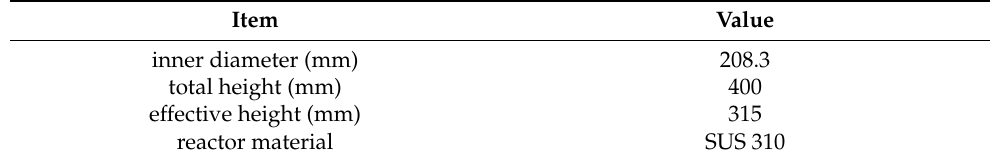
Figure 8. Rotary cylindrical reactor 1 & cavity 1. Table 1. Rotary cylindrical reactor